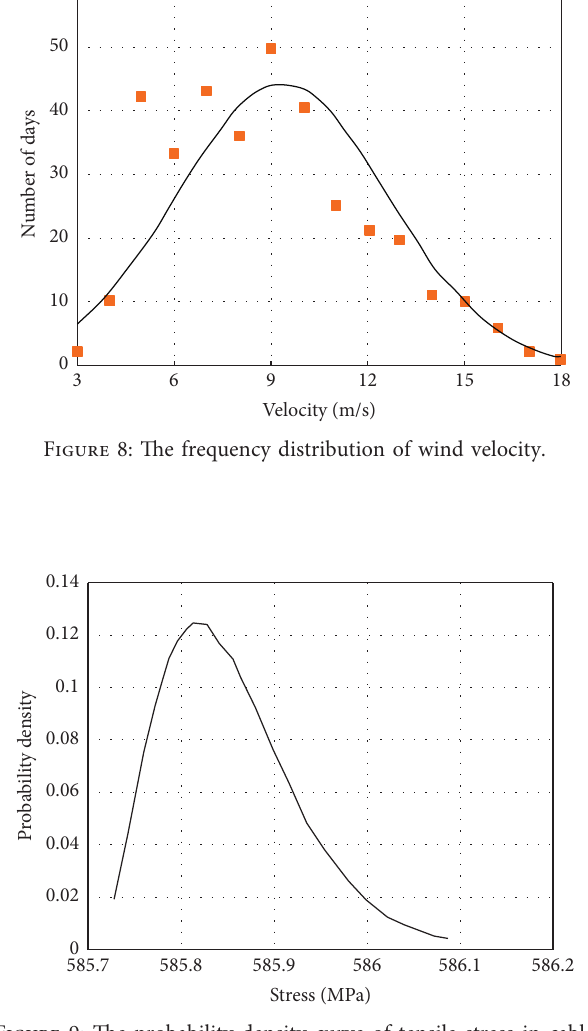
Figure 9: The probability density curve of tensile stress in cable sector 9 due to wind load